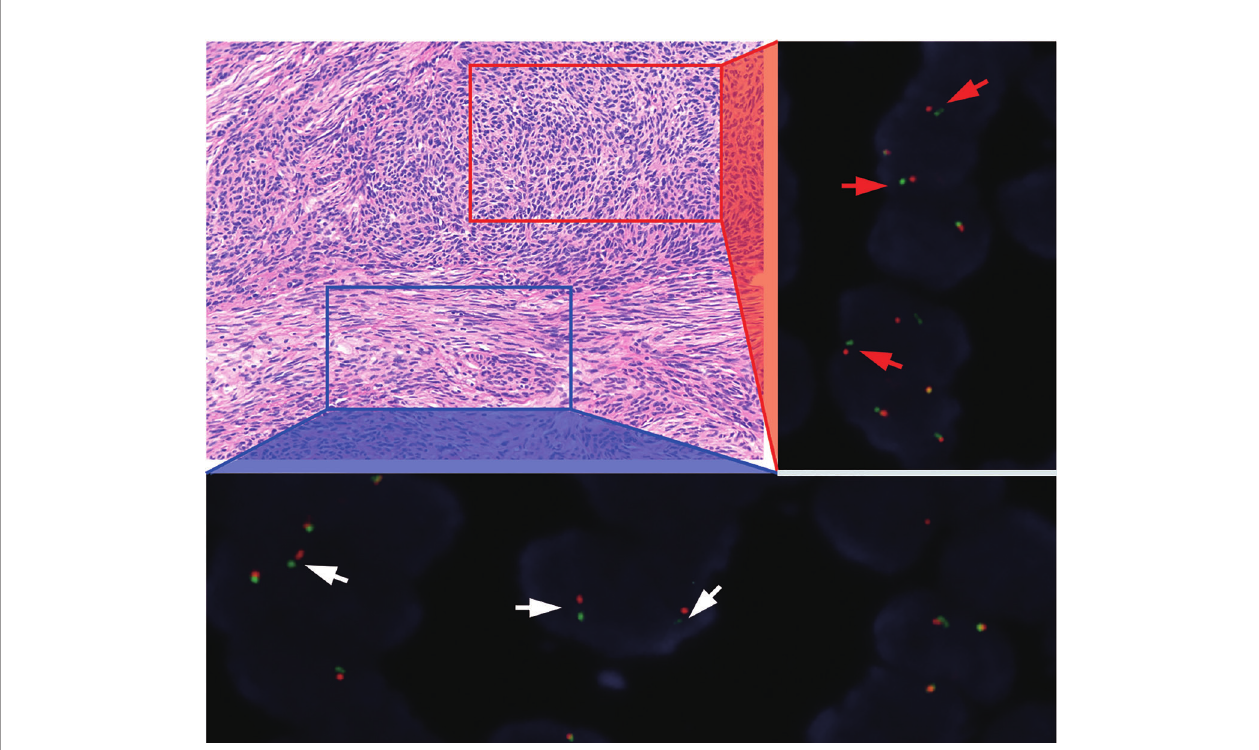
FIGURE 1 | Histological features of metaplastic thymoma. Anastomosing cords or trabeculae of epithelioid cell (red rectangle) and pseudosarcomatous spindle cell components (blue rectangle). H&E staining at 40X magni fi cation. Both epitheloid and spindle cell components harboring YAP1-MAML2 gene rearrangements are indicated by red and white arrows